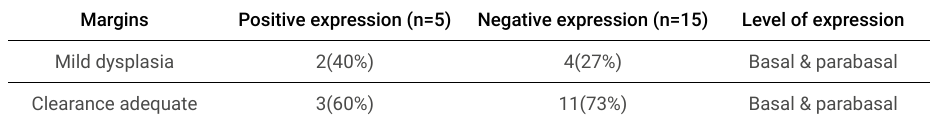
Table 3. Expression of cyclin D1 in the resected surgical apparently clear margins.